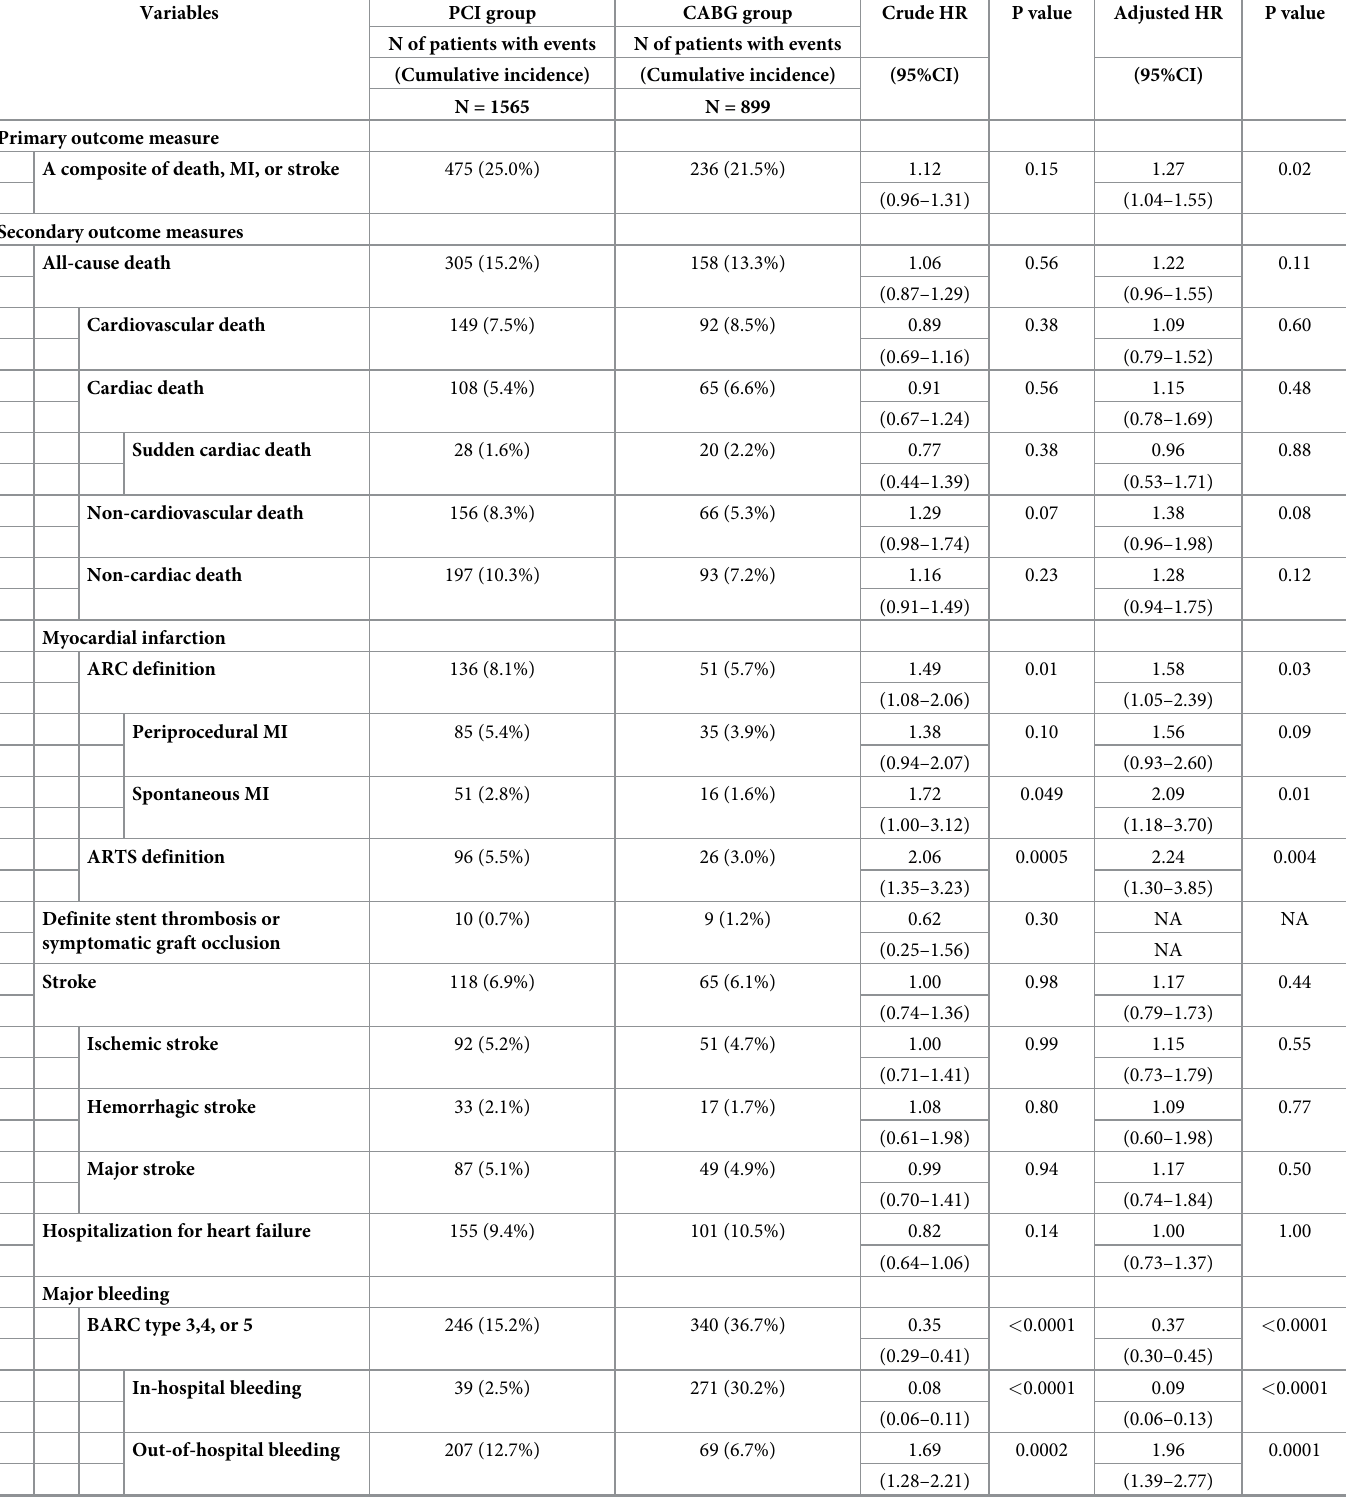
Table 3. Clinical outcomes: PCI group versus CABG